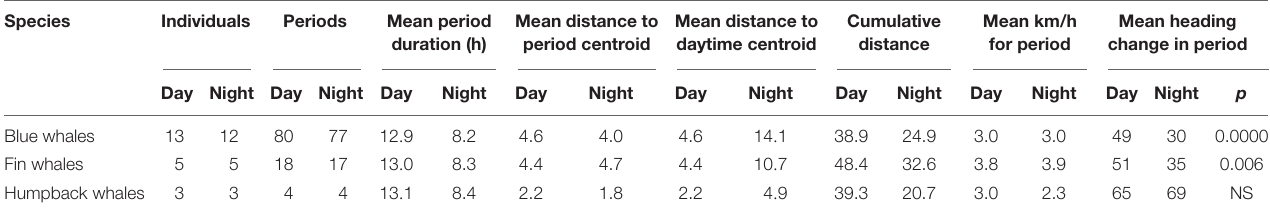
Mean distance to Mean distance to Cumulative Mean km/h Mean heading duration (h) period centroid daytime centroid distance for period change in